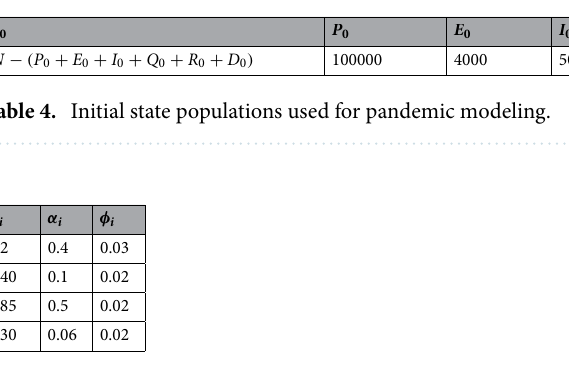
Table 5. Initial intervention parameters used for pandemic model